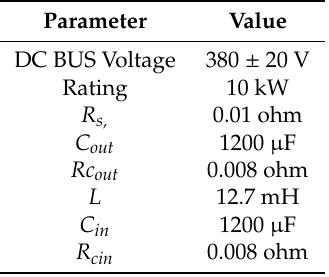
Table 1. Converter